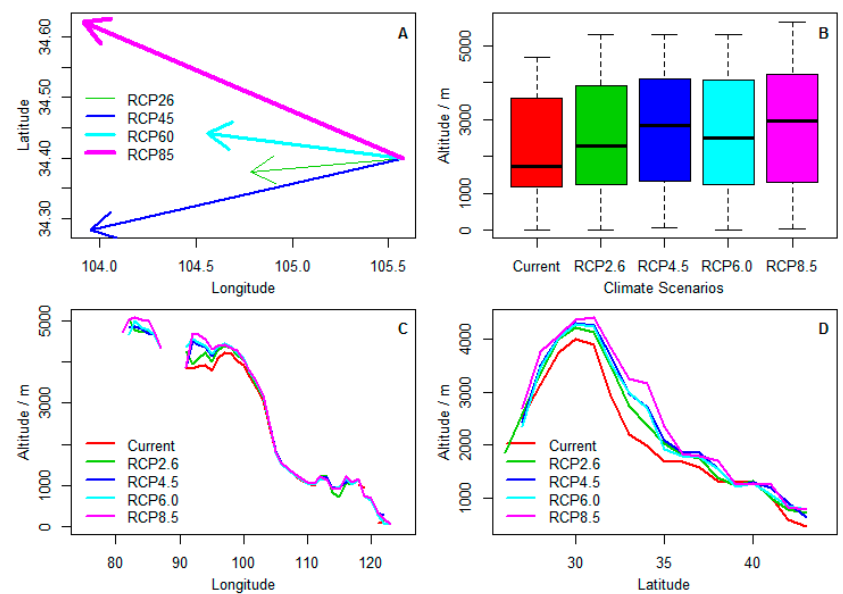
Figure 4. Climate-related centroids shift in three geographic dimensions of Chinese sea buckthorn under four climate change scenarios in the 2070s. ( A ) centroid shift of range along latitudinal and longitudinal gradients; ( B ) centroid shift of altitude; ( C ) centroid shift of altitude along the longitudinal gradient; ( D ) centroid shift of altitude along the latitudinal gradient.